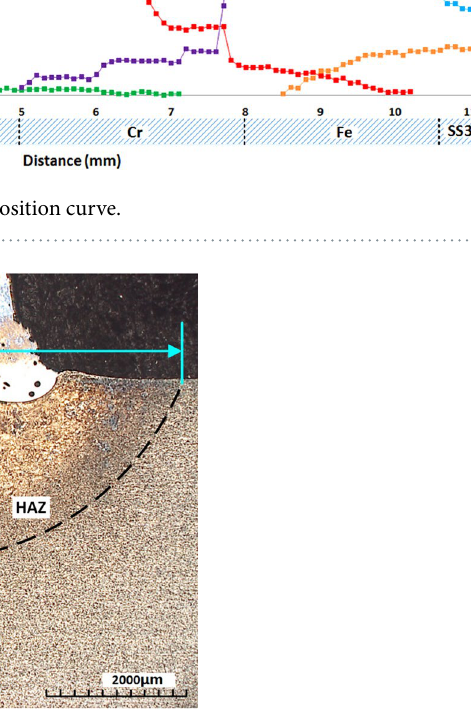
Figure 9. Heat affected zone (HAZ) in the